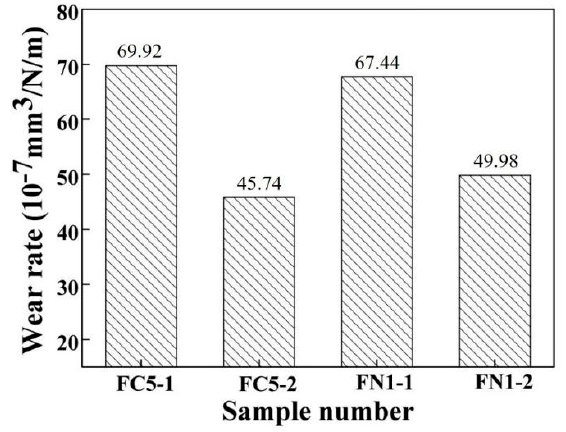
Figure 6. Wear rates of FGCs and conventional carbides.